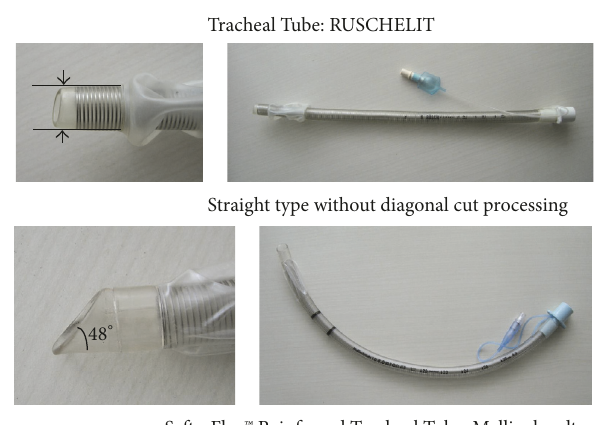
Figure 3: Straight type without diagonal tip. The R¨uschelit tube has an obtuse-angled tip; the Safety-Flex Reinforced tube has a slanted tip.